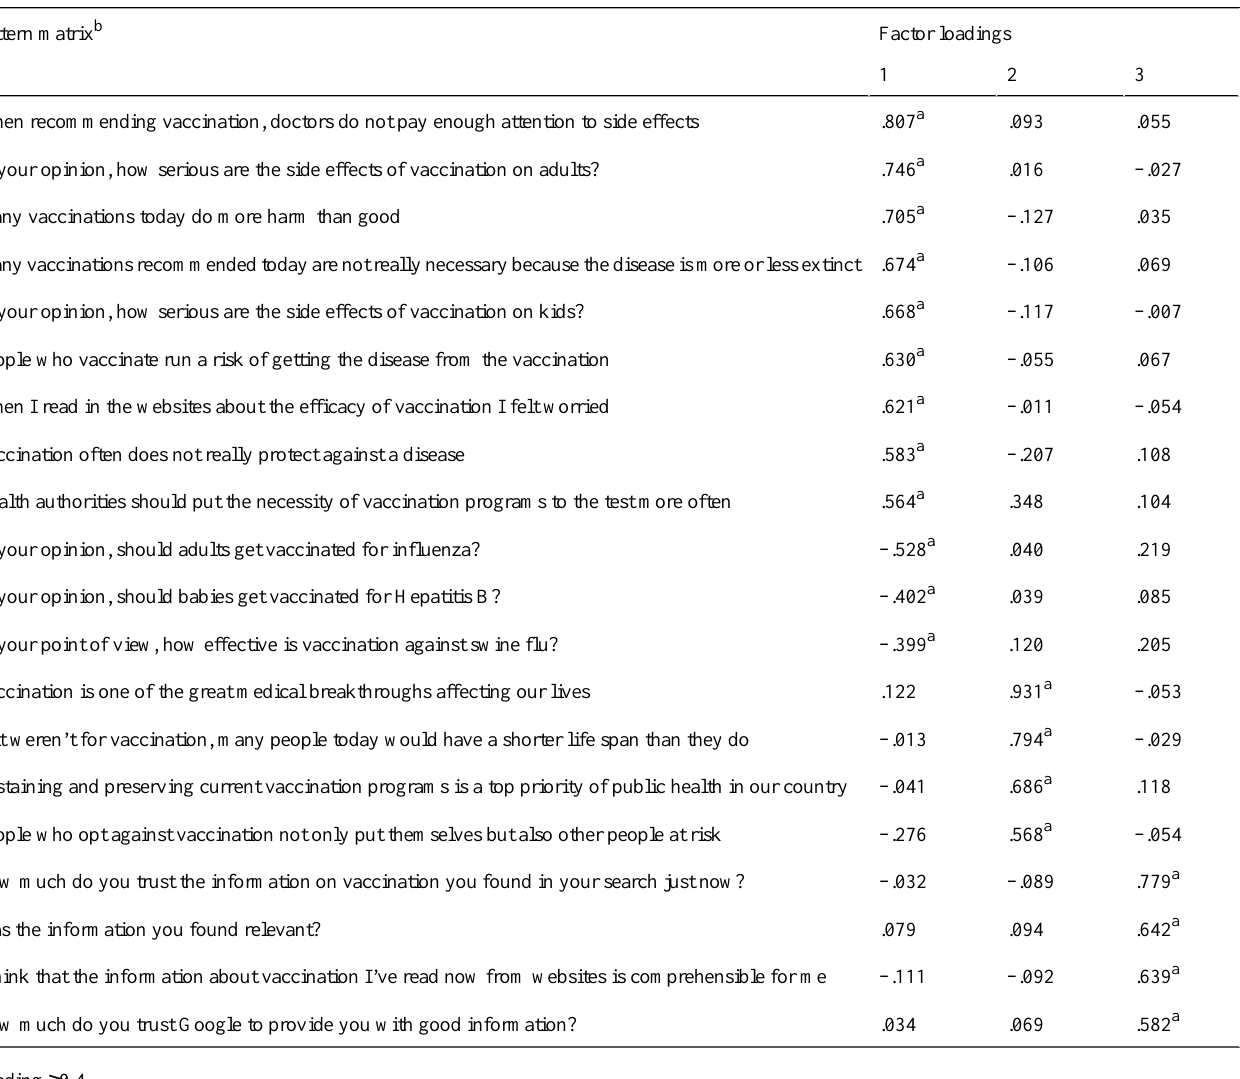
Table 1. Factor analysis of attitude and website assessment measures in experiment 2.